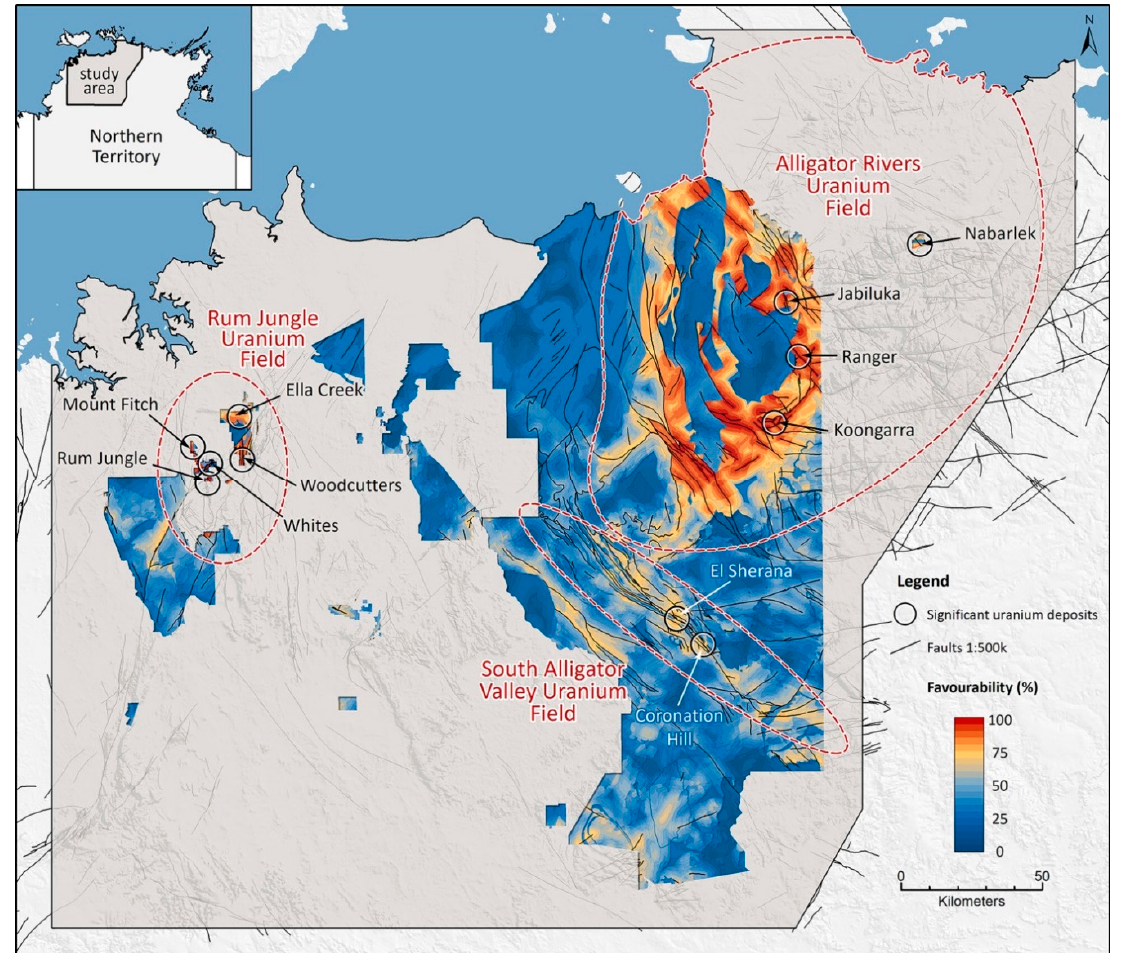
Figure 12. Final output from the NW McArthur Basin fuzzy logic mineral potential modelling for unconformity-type uranium. Warmer colours (orange to red) represent elevated prospectivity. The locations of significant unconformity-related uranium deposits are shown by black circles and the generalised extent of the Rum Jungle, Alligator Rivers and South Alligator Rivers uranium fields are outlined with red dashed lines. Due to the proprietary nature of the study, only results from areas within National Parks and mining leases are shown.